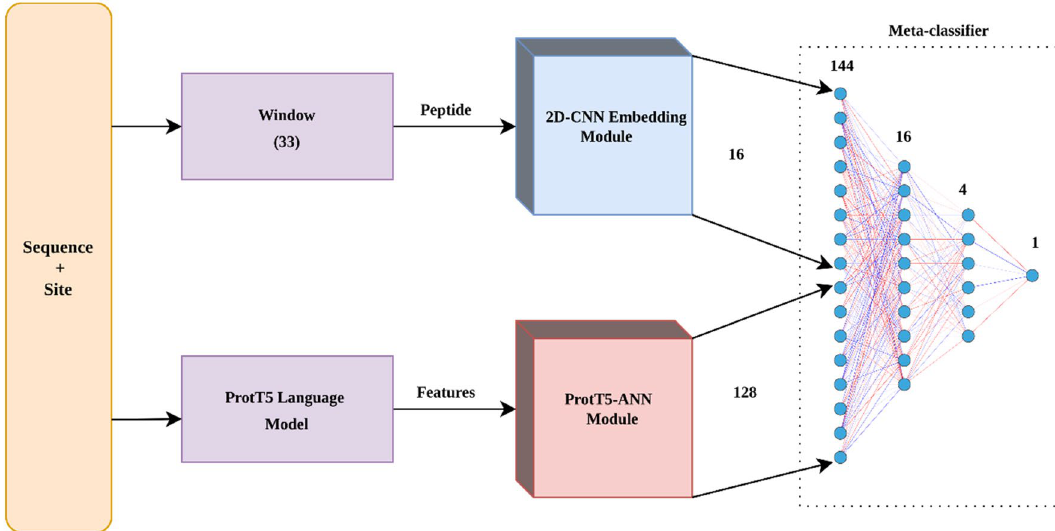
Figure 3. Model architecture of ensemble mechanism and meta